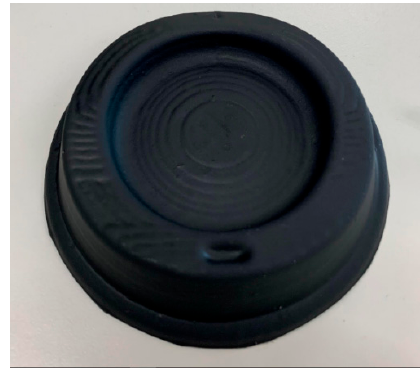
Figure 4. Thermoformed coffee lid made with 10 wt.% biochar from spent coffee grounds.